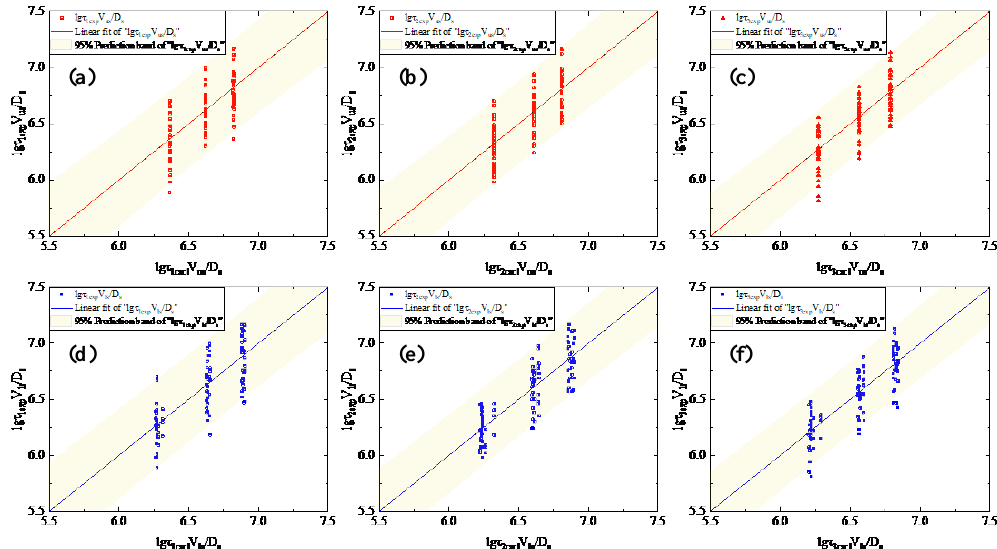
Figure 9. Comparison of experimental lg τV s / D s with calculated ones for upper side nozzle ( a ) and lower side nozzle ( b ), respectively, using proposed Equations (19) and (20).